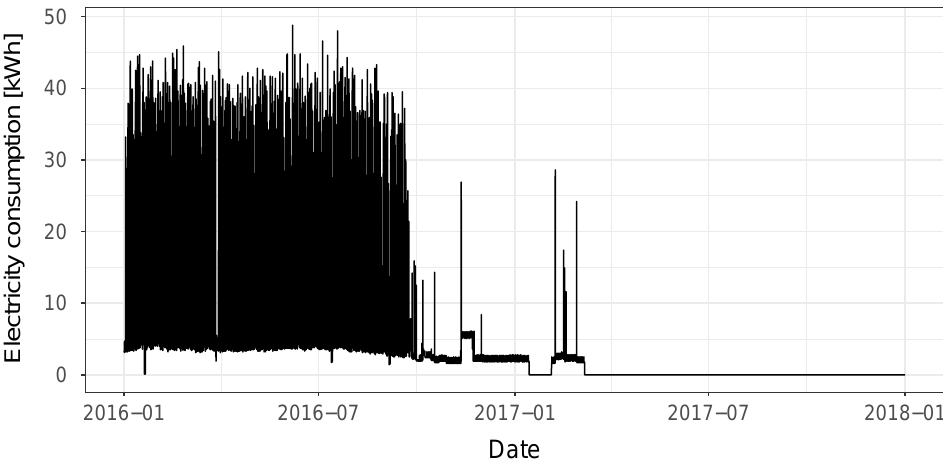
Figure 2. Electricity consumption time-series for the building Lamb_assembly_Delilah .